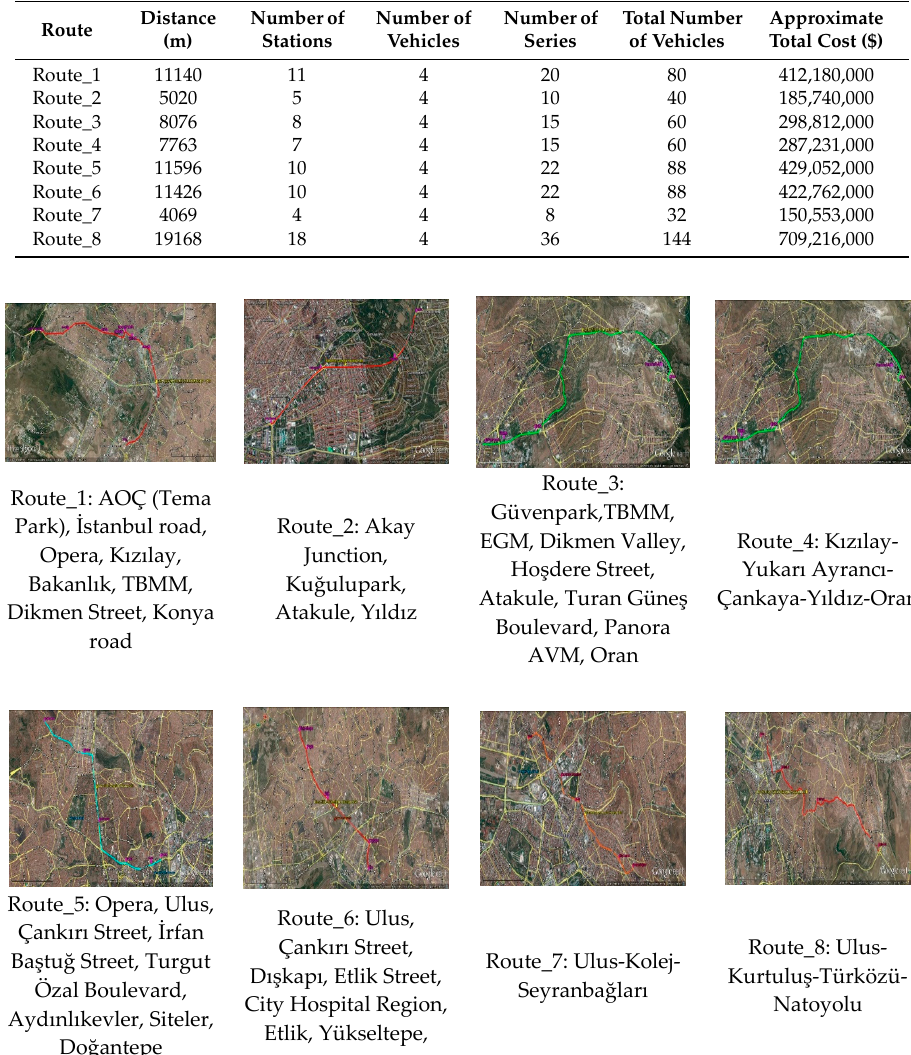
Table 1. Characteristic features of the routes.